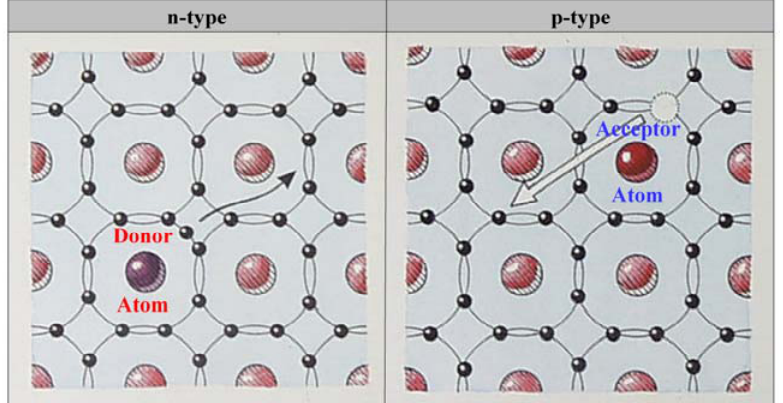
Figure 10. Schematic diagram of an n-type and p-type semiconductor material at the atomic